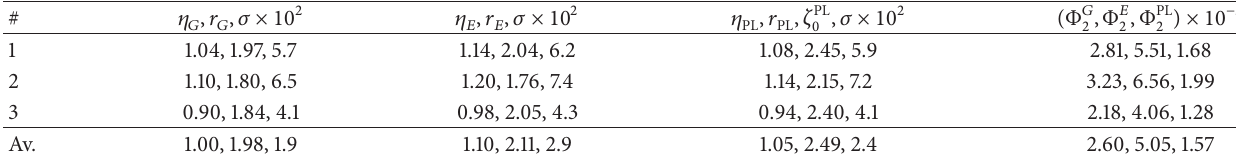
Table 4: The same as in Table 3 for generated 2D rough Gaussian surfaces with 𝑟 = 2 and 𝜂 = 1 . The expected value of Φ 2 ≈ 2.58 × 10 3 . The table contains the extracted fitting parameters 𝜂 fit 𝐺,𝐸, the results for the correlation function averaged over 10 independent